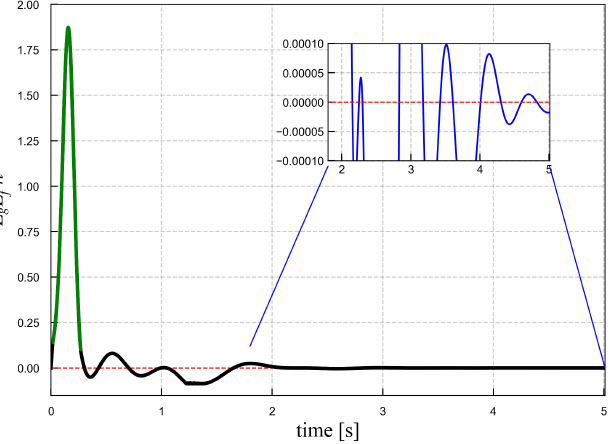
h —during an exemplary simulation trial. The green part of the Figure 4. Decoupling matrix— L g L 2 f plot indicates when the swing-up controller is